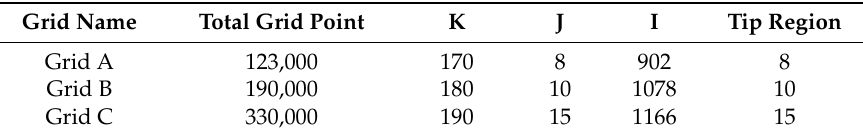
Table 4. Mesh statistic in the outer